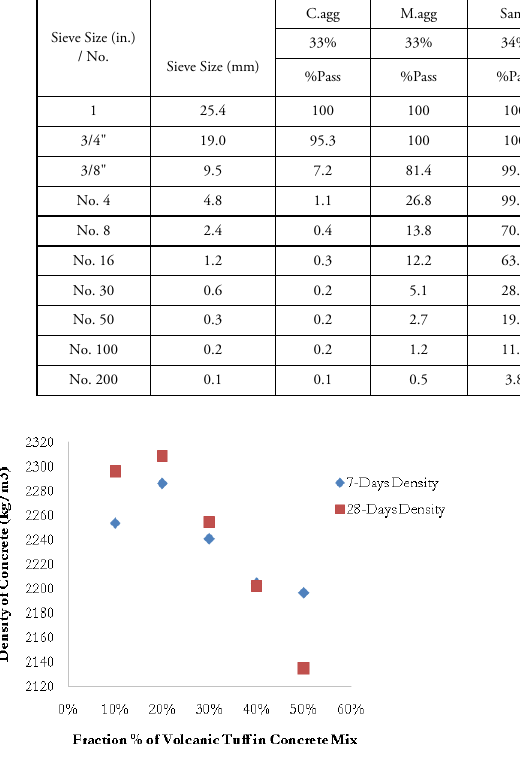
Fig.2. Density of volcanic lightweight concrete at 7- and 28-days Fig.3. Comparison of density of volcanic concrete (kN/m 3 )